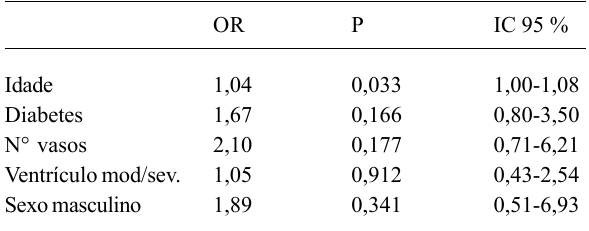
Tabela 3. Preditores independentes para complicação pós- operatória. Análise